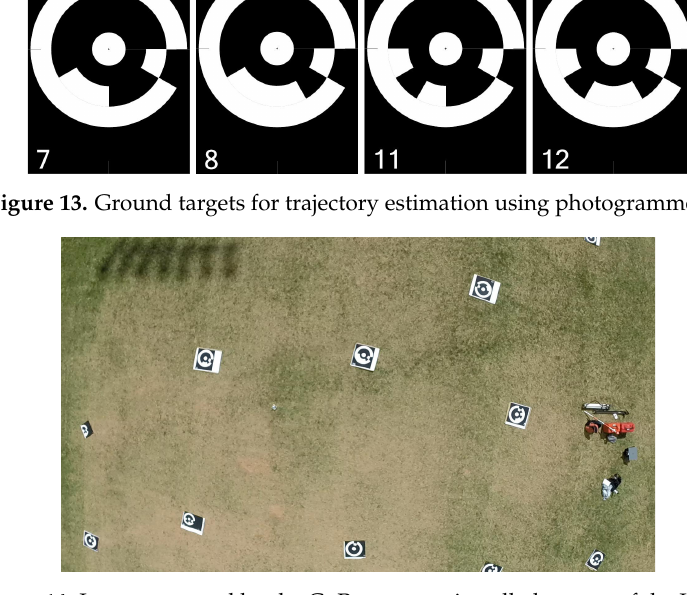
Figure 14. Image captured by the GoPro camera installed on one of the